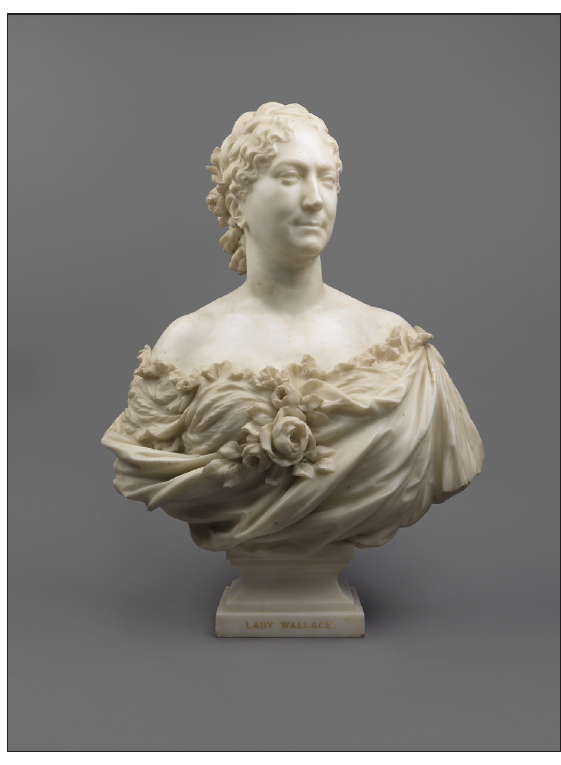
Fig. 7 : Charles-Auguste Lebourg, Lady Wallace , c. 1872, marble, 71 cm, Wallace Col- lection, S45. © The Trustees of the Wallace Collection,